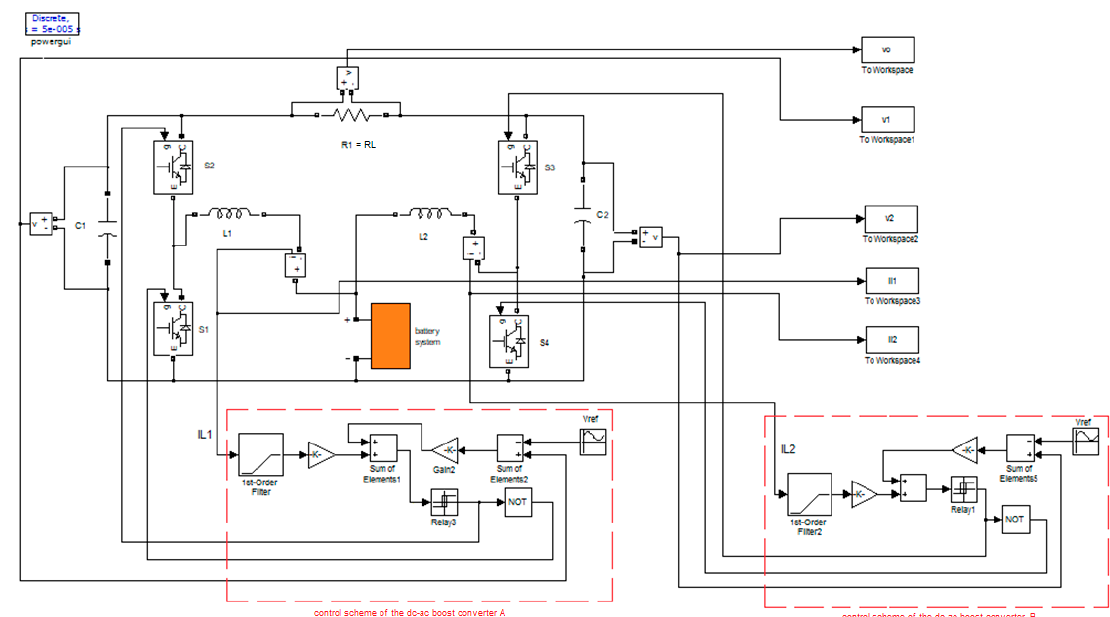
Figure 3. The general views of MATLAB / SIMULINK models for the boost dc-ac inverter. The conduction mode was given by Equation (8) [16].